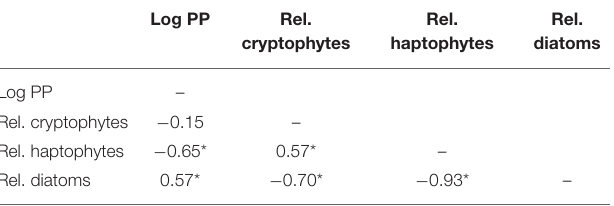
TABLE 2 | Spearman rank order correlations where log PP estimates ( n = 42) for the depths for which pigment samples were collected (with PP > 0) were